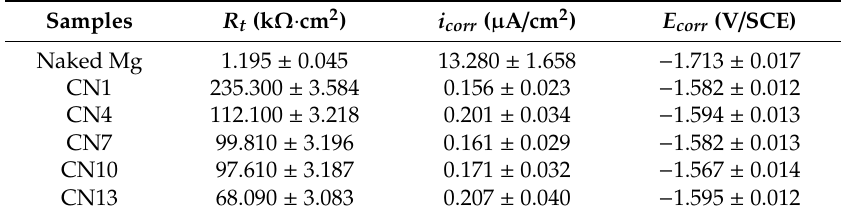
Table 2. Electrochemical properties of the naked Mg alloy and di ff erent Ca-P-coated samples.